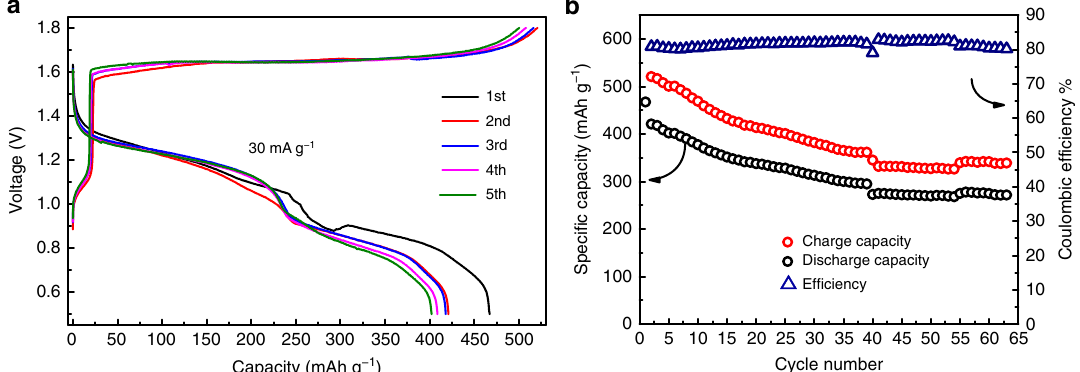
Fig. 4 Electrochemical performance of Al/Al(OTF) 3 -H 2 O/Al x MnO 2 · n H 2 O rechargeable battery. a Galvanostatic charge and discharge pro fi le. b Ef fi ciency and cycling